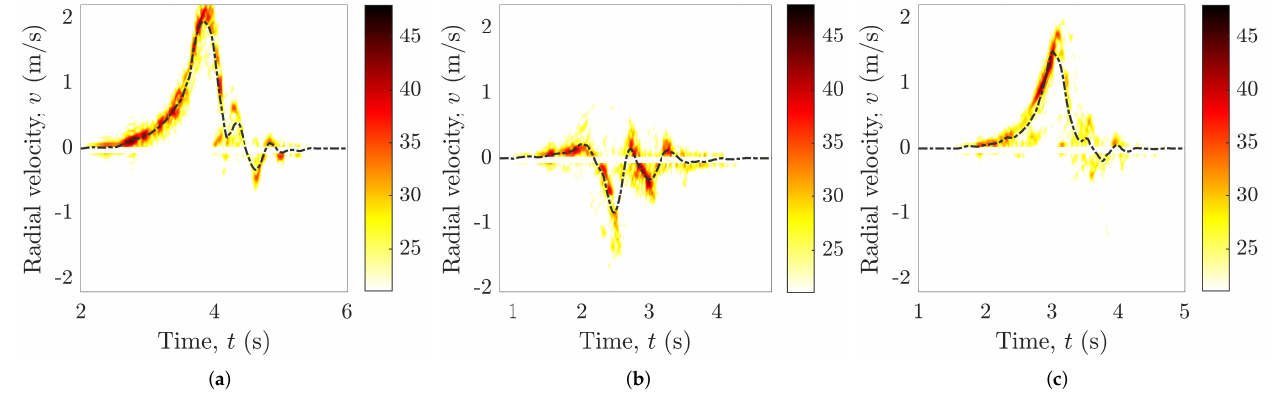
Figure 2. For a SISO radar system, the measured radial velocity distribution p 11 ( v , t ) and mean radial velocity ¯ v 11 ( t ) of a human falling activity for ( a ) Scenario 1, ( b ) Scenario 2, and ( c ) Scenario